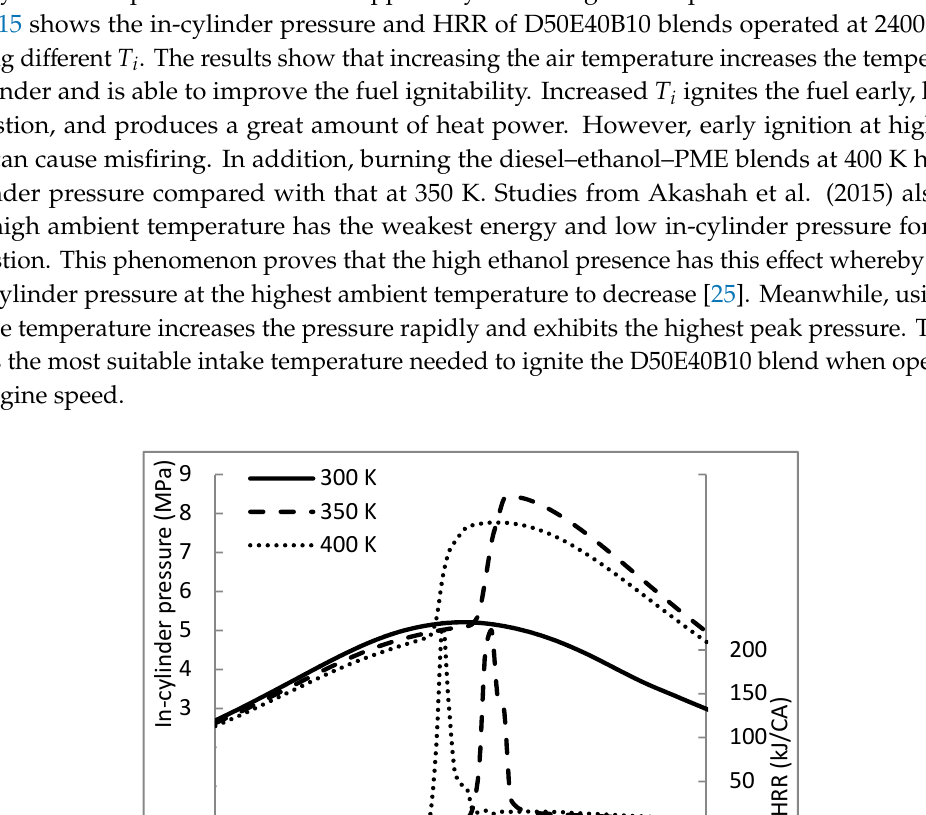
RPM by using a different intake temperature, T i . RPM by using a di ff erent intake temperature, T i